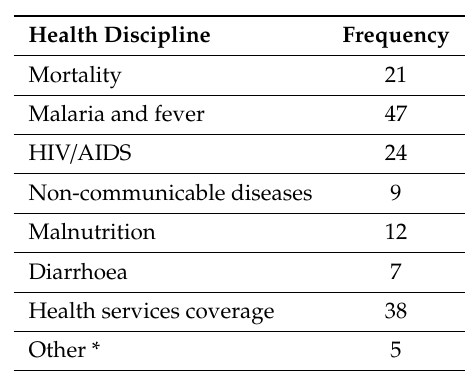
Table 3. Application areas of spatial